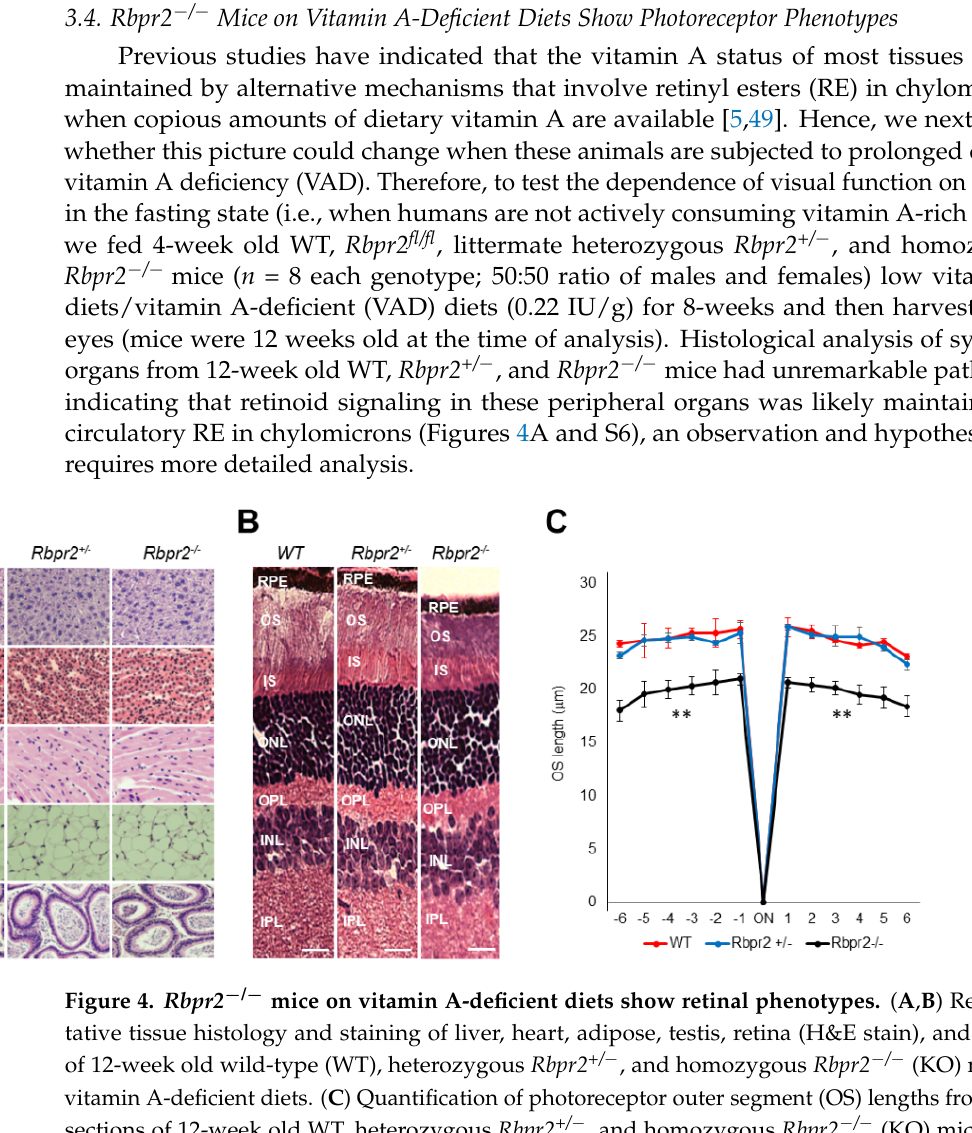
Figure 5. Rbpr2 − / − mice on vitamin A-deficient diets show decreased ocular retinoid concentra- tions and shorter photoreceptor outer segments. ( A ) Ultrastructural analysis of photoreceptors us- ing transmission electron microscopy (TEM): Representative TEM images of photoreceptors from 12-week old WT and Rbpr2 − / − mice on vitamin A-deficient diets are presented. Scale bar = 600 µm.